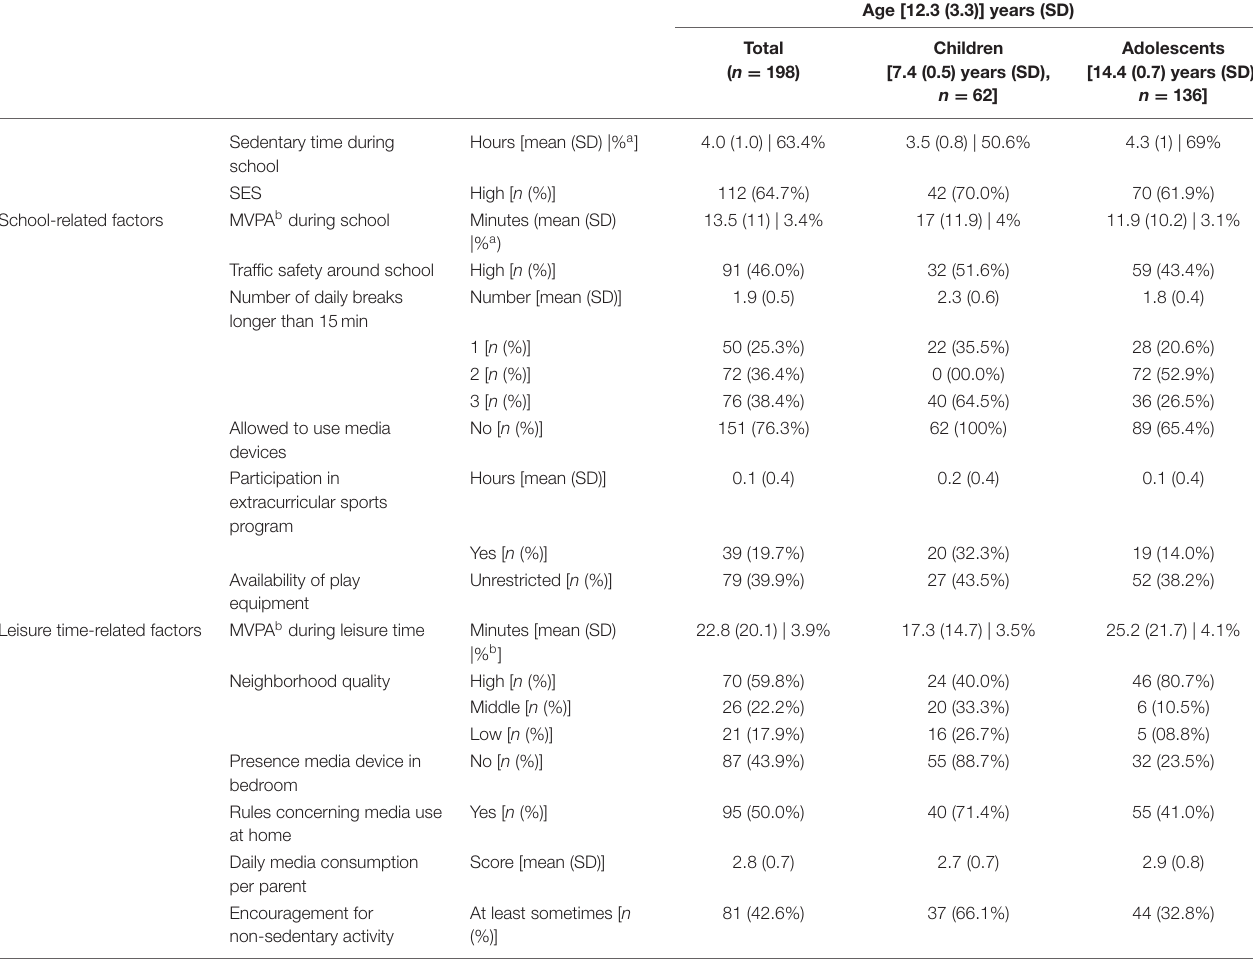
TABLE 1 | Characteristics of the study population.